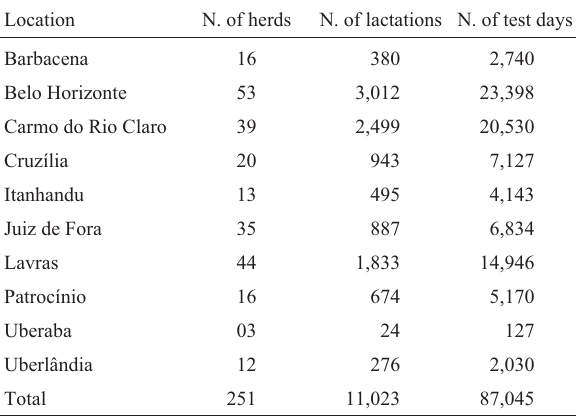
Table 1 - Summary of the information used in this study.